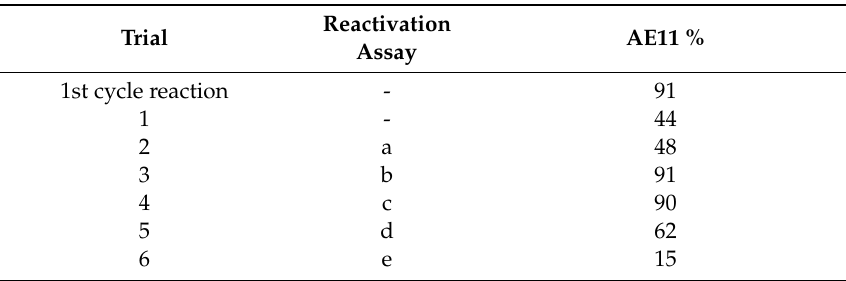
Table 11. E ffi ciency of the reactivation assays tested in a second cycle hydrogenation of UNE11. AE11 : methyl-11-aminoundecanoate.